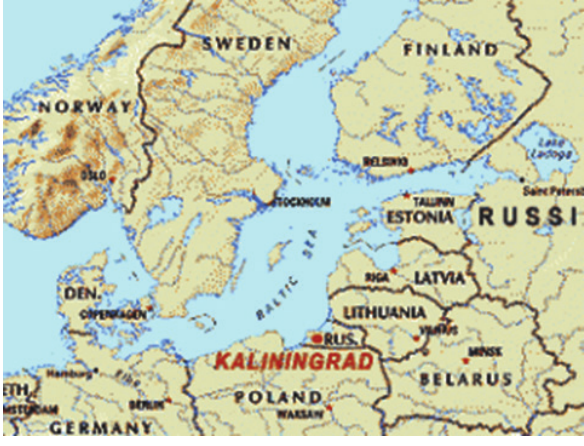
Figure 8. The region of study – Kaliningrad